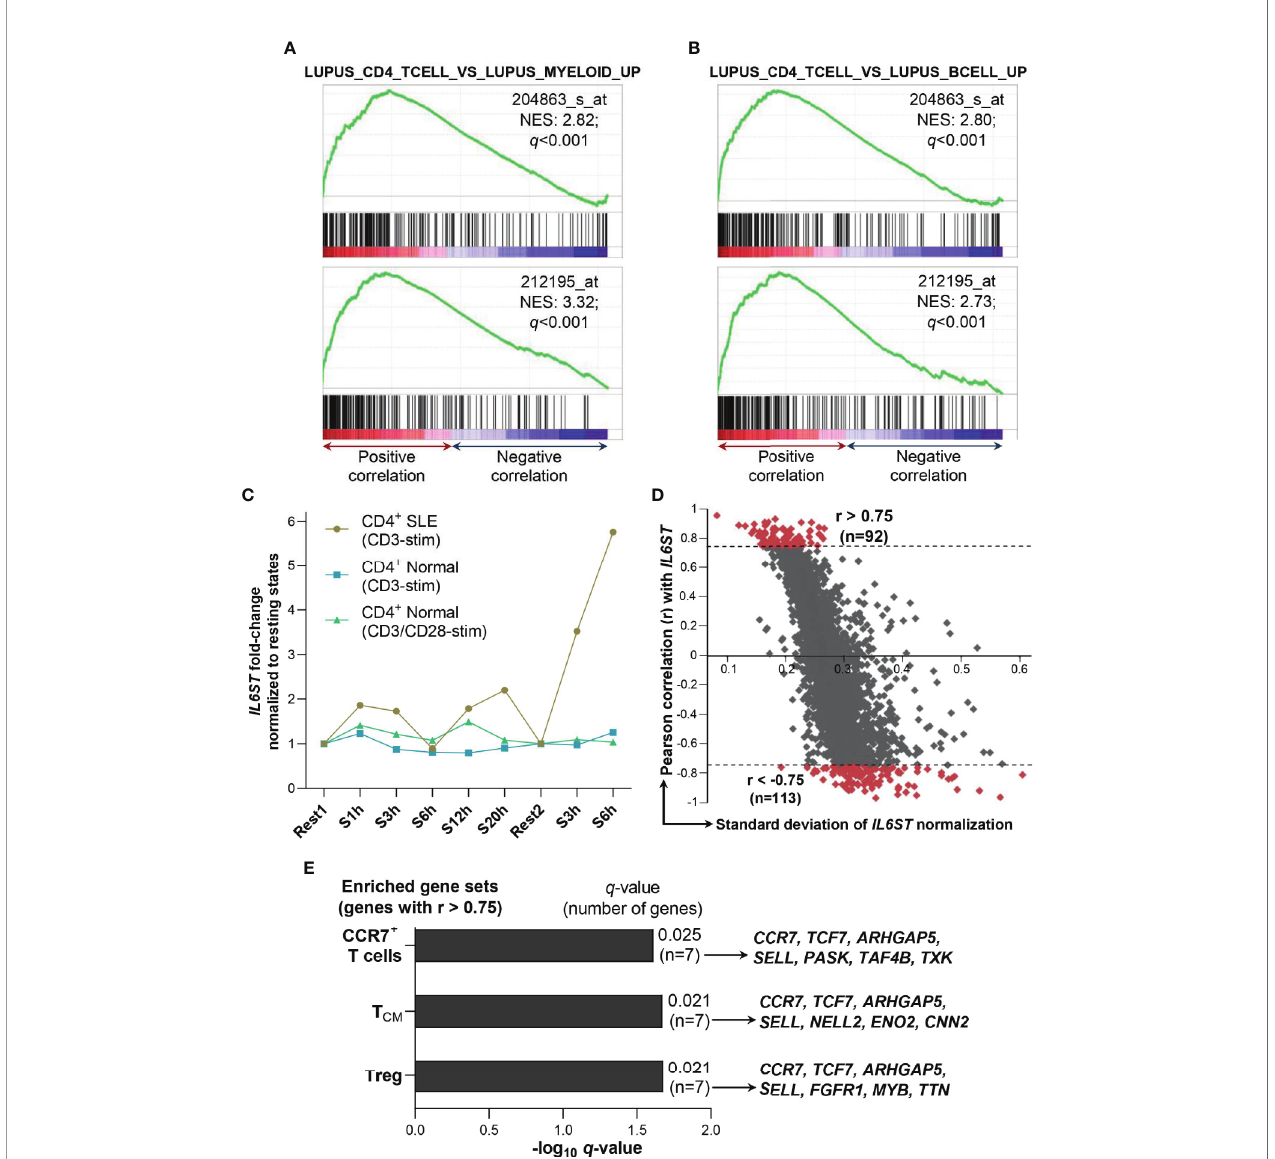
FIGURE 5 | Association of IL6ST expression with T cell subsets in SLE patients. (A) IL6ST expression levels were signi fi cantly associated with SLE CD4 + T cells compared with SLE myeloid cells gene set (GSE10325_LUPUS_CD4_TCELL_VS_LUPUS_MYELOID_UP; ID: M3087) according to GSEA utilizing two independent IL6ST probes (204863_s_at and 212195_at) in SLE patients (n=8; GSE4588 dataset). (B) IL6ST expression levels were signi fi cantly associated with SLE CD4 + T cells compared with SLE B cells gene set (GSE10325_LUPUS_CD4_TCELL_VS_LUPUS_BCELL_UP; ID: M3084) according to GSEA utilizing two independent IL6ST probes (204863_s_at and 212195_at) in SLE patients (n=8; GSE4588 dataset). (C) IL6ST expression in CD4 + T cells of SLE patients or normal controls (n=9 for each group) stimulated with anti-CD3 or anti-CD3/anti-CD28 (control samples only) in GSE1057 dataset. IL6ST expression in each stimulated samples was normalized to their corresponding resting states i.e. S1h (stimulated for 1 hour), S3h, S6h, S12h and S20h were normalized to Rest1, while the second group of S3h and S6h (each stimulated after 3 days of resting) were normalized to Rest2 (unstimulated for 3 days). CD4 + SLE: CD4 + T cells derived from SLE patients; CD4 + Normal: CD4 + T cells derived from normal subjects; CD3-stim: Stimulated with anti-CD3 antibody; CD3/CD28-stim: Stimulated with anti-CD3 and anti-CD28 antibodies. (D) Correlation of IL6ST with 9,128 genes in SLE patients (n=9) i.e. Rest1, S1h, S3h, S6h, S12h and S20h, and Rest2, S3h and S6h as described previously. The Pearson r value ±0.75 was used as the cut-off to de fi ne positive (>0.75) or negative (<-0.75) association with IL6ST . (E) Gene sets enriched from genes positively associated with IL6ST expression (r>0.75) as shown in (D) according to ImmuneMap database. All q -values were obtained with the Benjamini-Hochberg correction. NES, Normalized enrichment